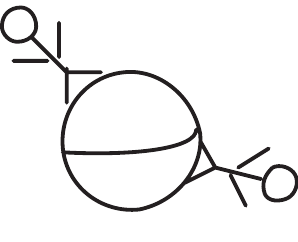
FIG. 4. (cid:1) Color (cid:2) “ (cid:1) T (cid:2) he book would just (cid:3) G-M (cid:4) fly off into